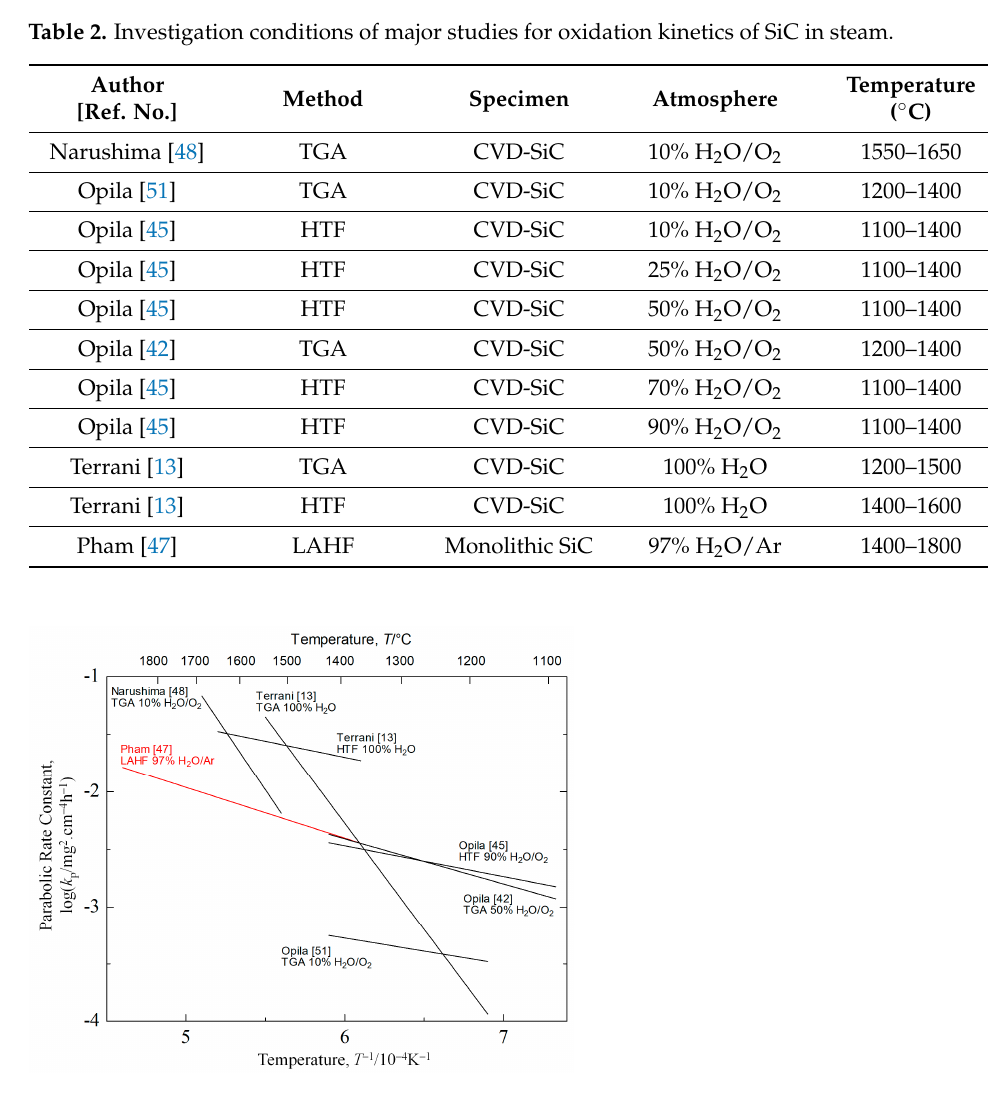
Figure 7. Influence of steam partial pressure on parabolic oxidation rate constant reported by Opila [45]. Impurities from environment can also affect the oxidation of SiC in steam at high temperatures. Opila [51] investigated the oxidation kinetics of CVD-SiC at 1200–1400 ° C in 10 vol% H 2 O/O 2 mixture using TGA with either pure Al 2 O 3 or fused quartz reaction tubes. Results of the investigation (Figure 8) indicated that the parabolic oxidation rate of SiC samples tested in Al 2 O 3 reaction tube was about one order of magnitude higher than that of SiC samples tested in quartz tube. It was found that the steam oxidation of SiC in Al 2 O 3 reaction tube led to sodium and aluminum contamination of the oxide scale. The sodium and aluminum might be transported from the Al 2 O 3 reaction tube to the SiC sam- ple surface in the gas phase to form less protective oxide scales.